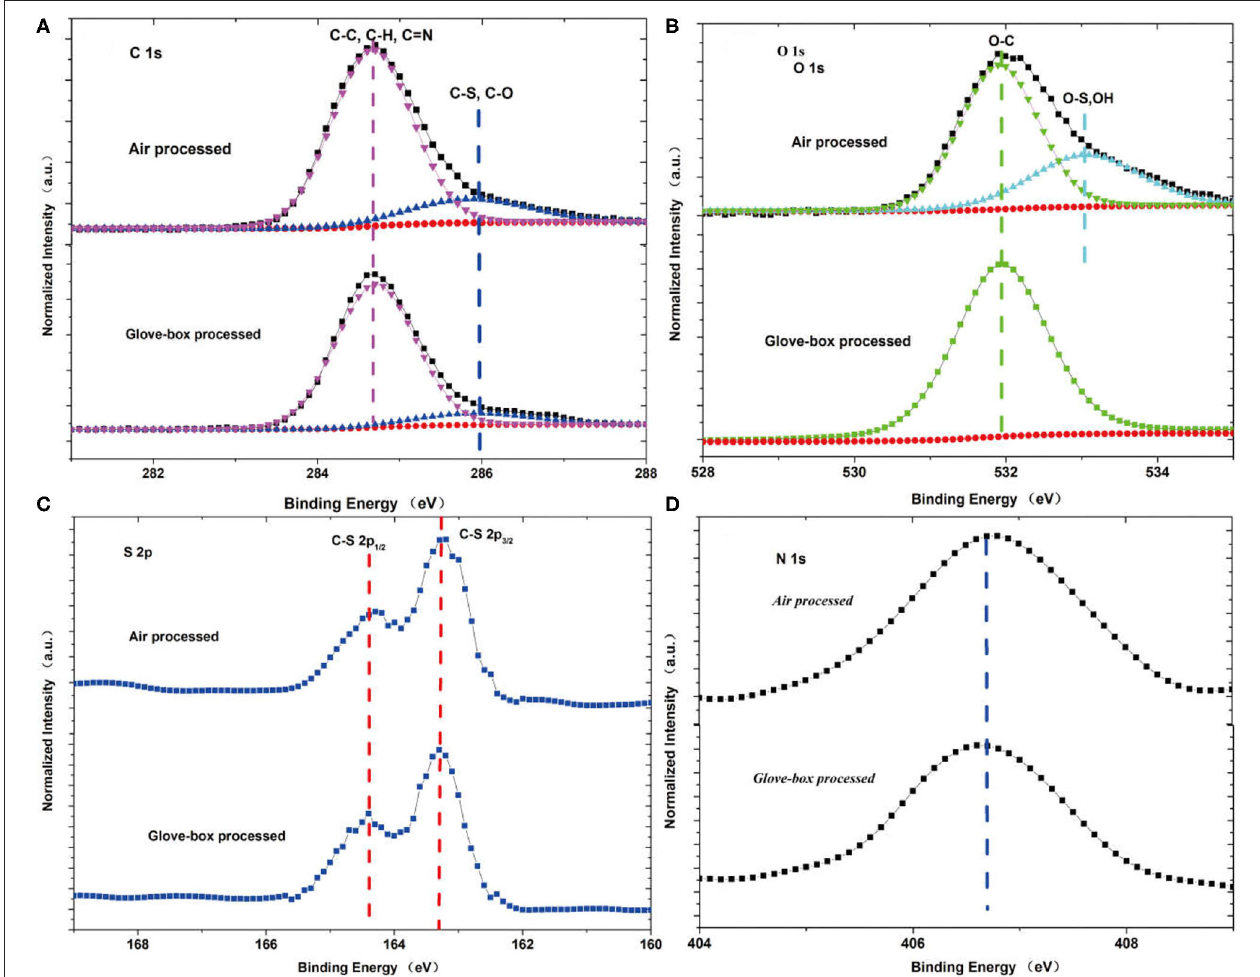
FIGURE 2 | XPS measurements on the (A) C1s, (B) O1s, (C) S2p, and (D) N1s spectra of the active layers that are air-processed and glove-box-processed.